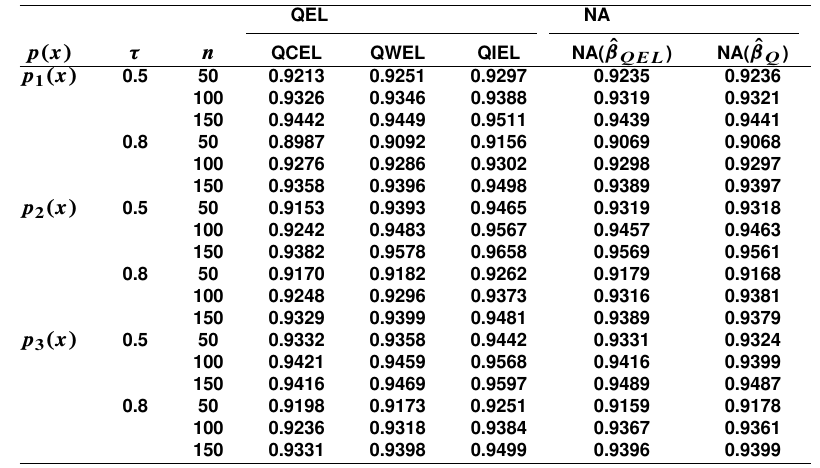
Table 4. Emprical coverage probabilities of the intervals for ˇ in Model 2 for different forms of the selection probability function p.x/ and different values of sample sizes n and (cid:28) under nominal level